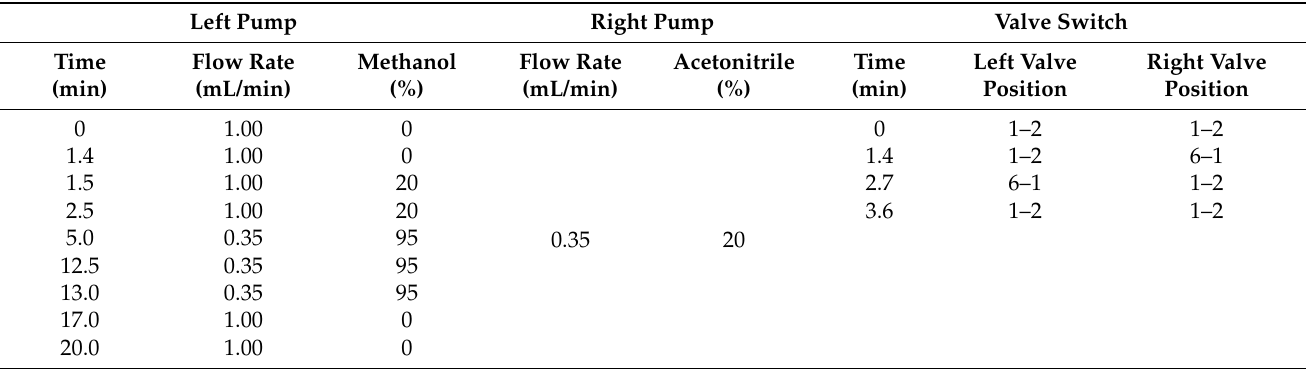
Table 3. Molecular structure and optimized MRM parameters for 9 N-nitrosamines.